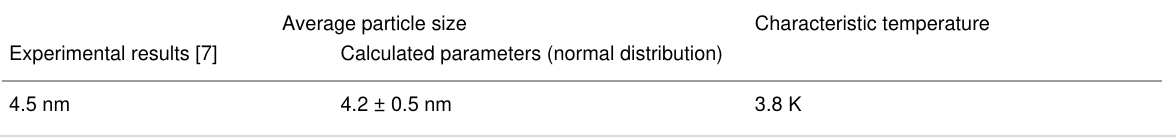
Table 2: Comparison between the experimental results for the particle size according to Li et al. [8] and the parameters calculated using Equation 7. Average particle size